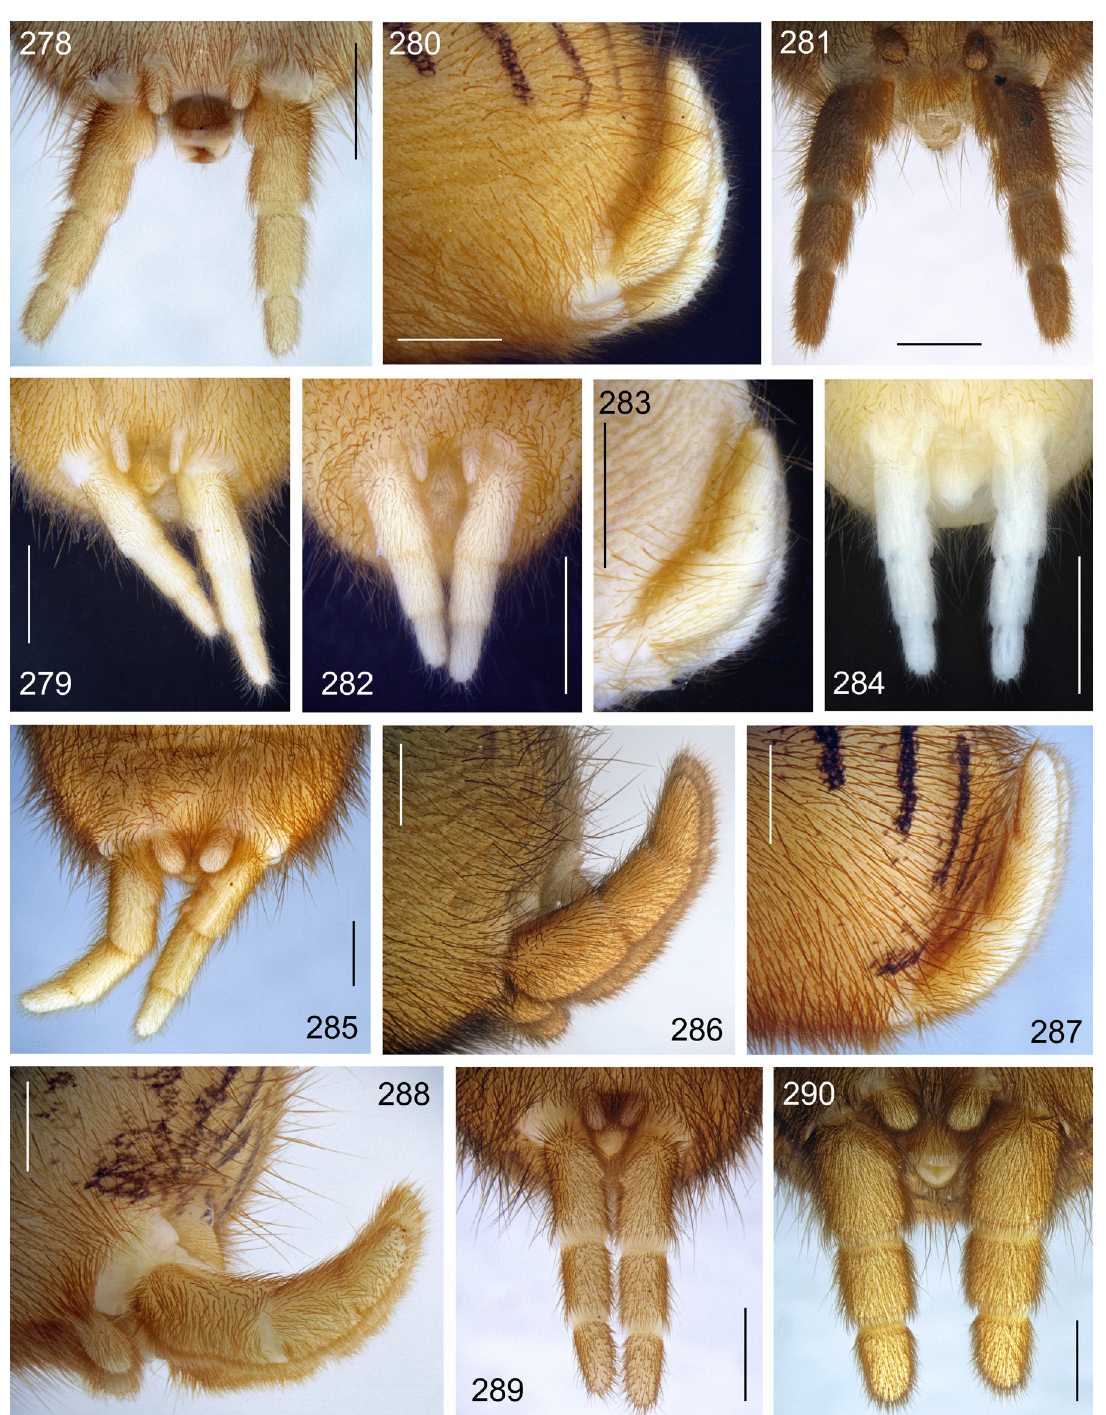
Figs 278–290. Anemesia spp., ♀♀ (278, 281, 283, 285, 286, 288, 290) and ♂♂ (279–280, 282, 284–285, 287, 289), spinnerets; ventral (278–279, 281–282, 284–285, 289–290) and lateral (280, 283, 286–288) views. 278 . A. sogdiana sp. nov. (paratype, Amankutan). 279 . A. castanea sp. nov. (holotype). 280– 281 . A. karatauvi (Andreeva, 1968) (Hojamaston). 282–283 . A. pallida sp. nov. (holotype and paratype from Ganjina). 284 . A. parvula sp. nov. (holotype). 285–286 . A. incana Zonstein, 2001 (holotype and paratype). 287–288 . A. infumata sp. nov. (holotype and paratype). 289–290 . A. infuscata sp. nov. (holotype and paratype from Varzob). Scale bars: 1.0